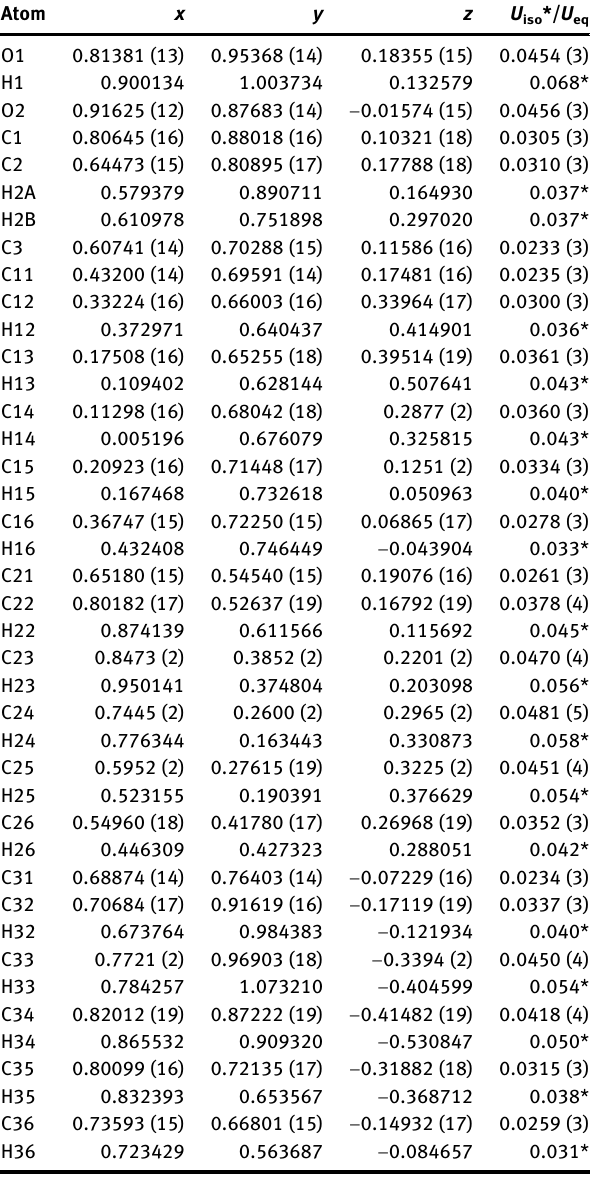
Table  : Fractional atomic coordinates and isotropic or equivalent isotropic displacement parameters (Å 